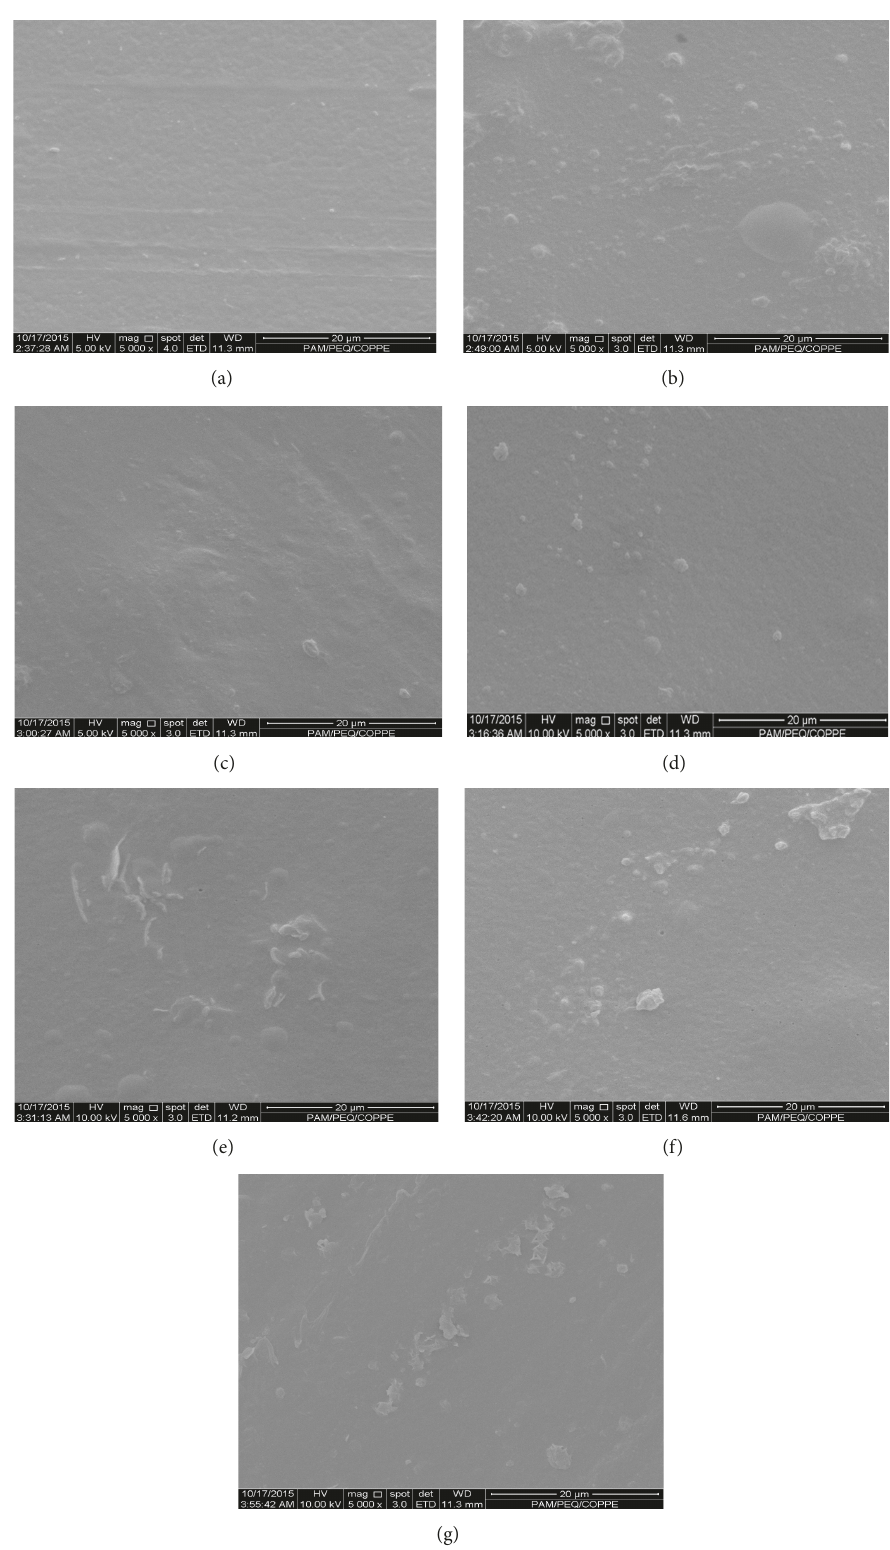
Figure 2: SEM of the surface of the films. PBAT (a), PBAT/TPS (b), 70/30/1% (c), 70/30/2% (d), 70/30/3% (e), 70/30/4% (f), and 70/30/5% (g). Magnification: